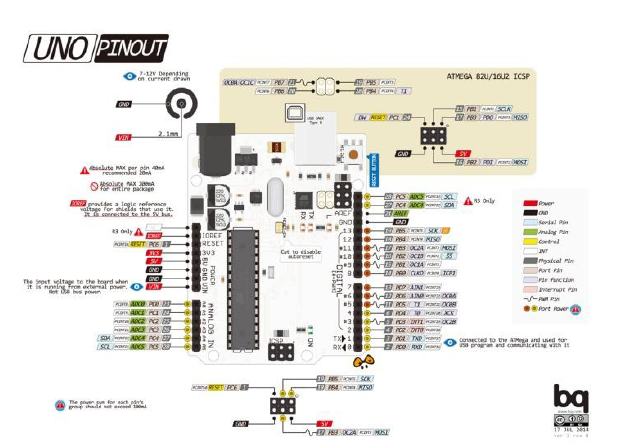
Figure 4. Pinout of Arduino Uno R3